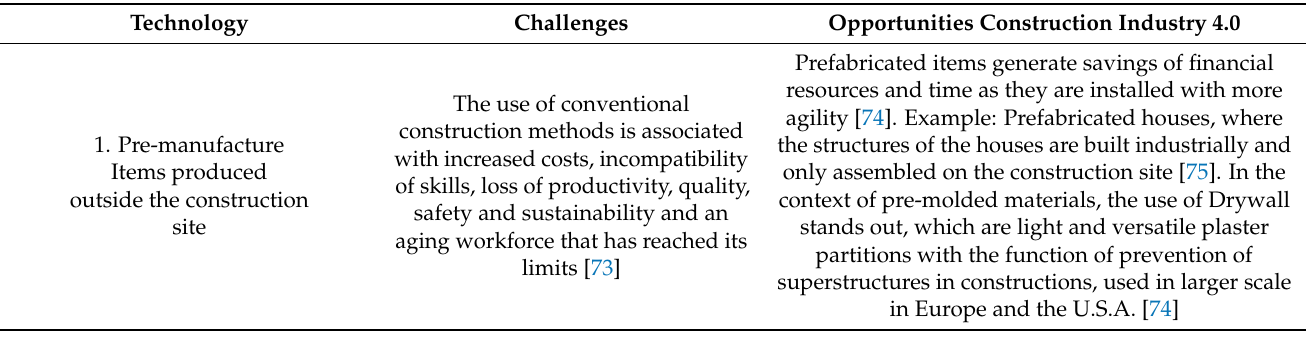
Table 3. Challenges and Opportunities in the construction sector. Source: elaborated by the authors. Technology Challenges Opportunities Construction Industry